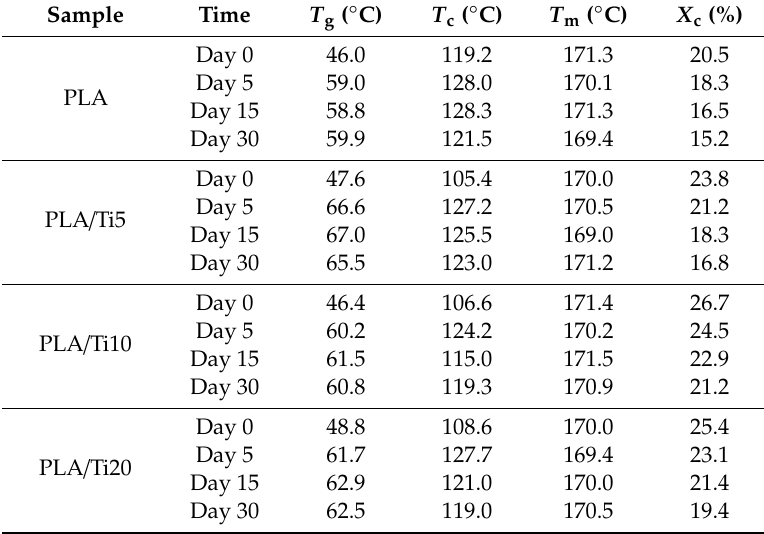
Table 3. The thermal properties of PLA / nano-TiO 2 composite films after high pressure treatment.